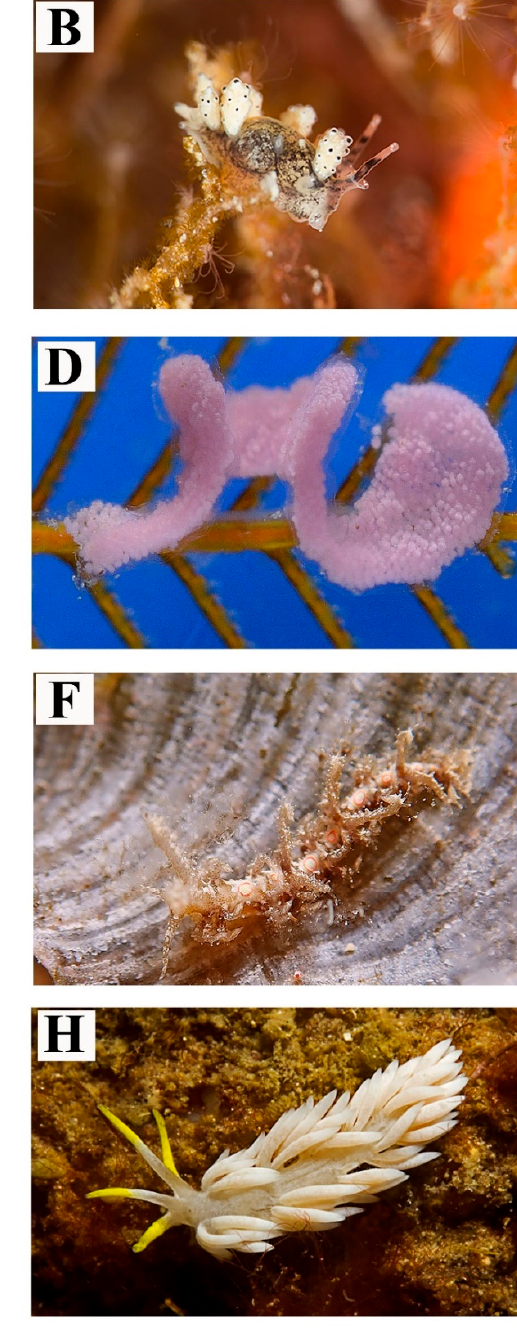
Figure 4. ( A ) Tritonia nilsodhneri . St. 18 ( B ) Doto cervicenigra . St. 11 ( C ) Doto floridicola . St. 22 ( D ) Spawn Figure 4. A. Tritonia nilsodhneri . St. 18 B. Doto cervicenigra . St. 11 C. Doto floridicola . St. 22 D. Spawn of of Doto floridicola . St. 22 ( E ) Paraflabellina gabinierei . St. 11 ( F ) Limenandra nodosa . St. 3 ( G ) Caloria elegans . Doto floridicola . St. 22 E. Paraflabellina gabinierei. St. 11 F. Limenandra nodosa . St. 3 G. Caloria elegans . St. St. 11 ( H ) Dicata odhneri St. 11 H . Dicata odhneri St. 11.